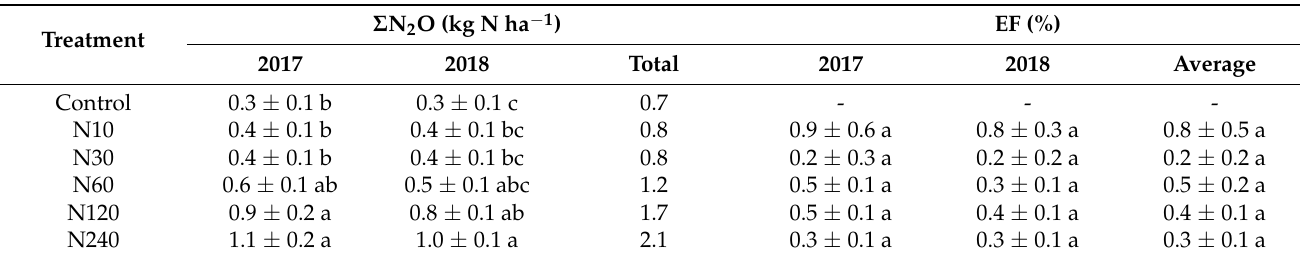
Table 1. Cumulative N 2 O emissions ( Σ N 2 O) and applied-N scaled emission factors (EF) as affected by N addition treatments in 2017 and 2018 growing seasons.